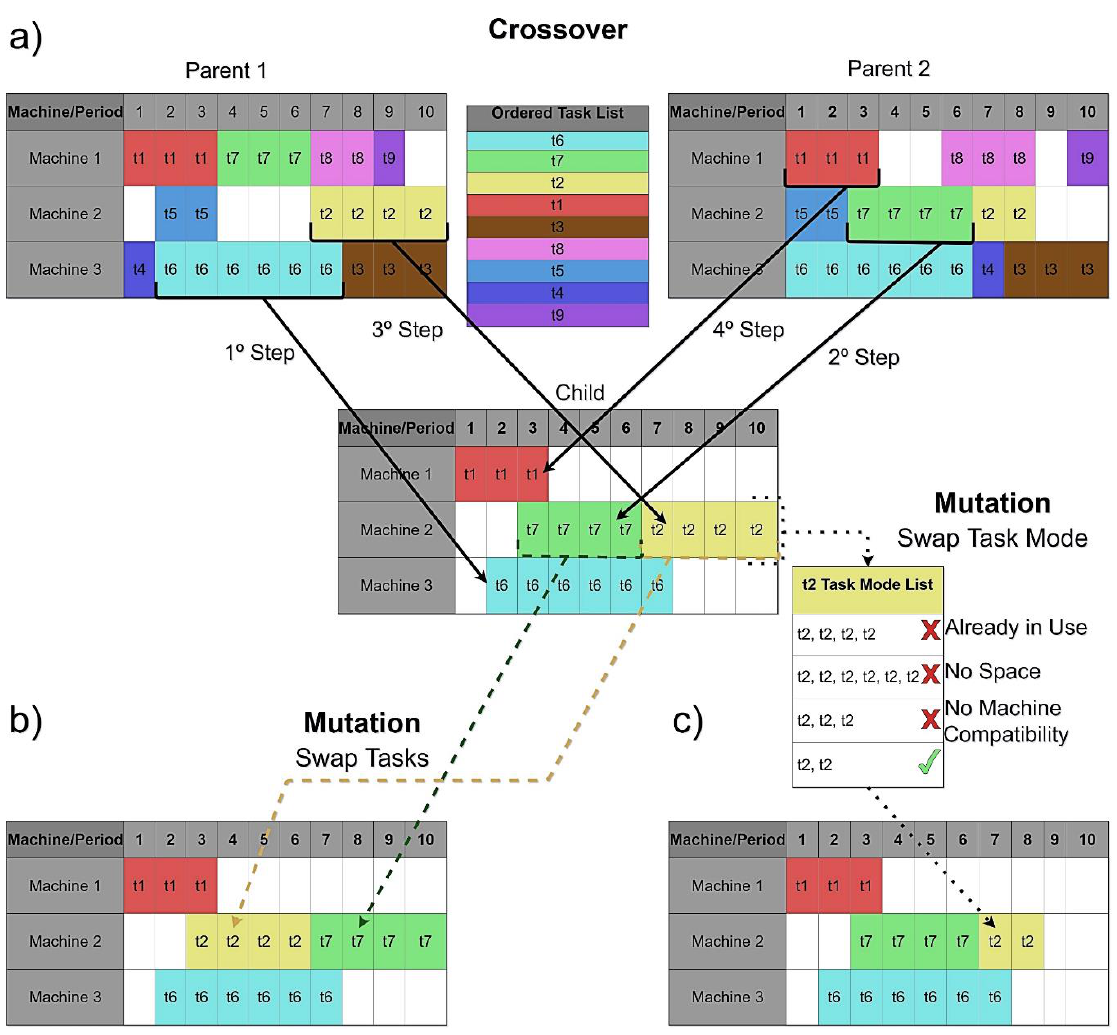
Figure 4. Individuals’ crossover and mutation. ( a ) Example of the first 4 steps in a crossover, starting from parent 1; ( b ) example of a swapping tasks mutation; ( c ) example of a swapping the task mode on a task mutation.